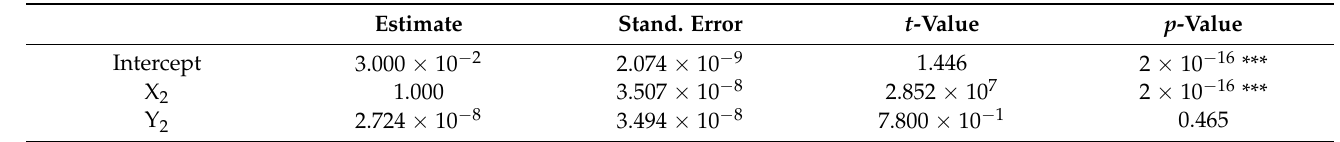
Table 3. Coefficients of MLRM for the experimentally fixed rate constant at 420 ◦ C with a difference of 0.03. Where ‘***’ shows a statistically significant value. Stand. Error